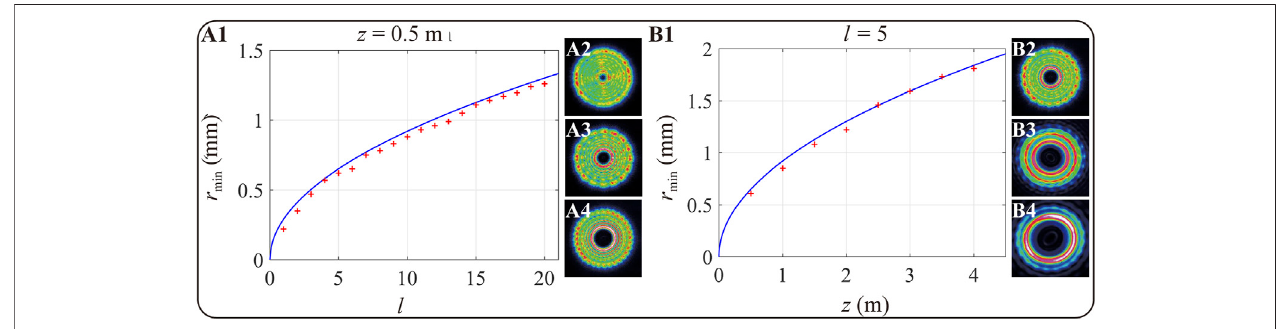
FIGURE4| Evolutionaryprocess oftheminimum radius ofthe darkring ofavortex beam variation with l and z in theexperiment. Therelationship between r min and (A1) the topological number l and (B1) the propagation distance z . The blue solid line is the simulation result, and the “ + ” marks are the experimental results. The measured intensity distributions for the vortex beam (A2 – A4) at the propagation distance z = 0.5 m with the topological number l are 1, 4, and 8, and (B2 – B4) the topological number l = 5 and the propagation distance z are 0.5, 1.5 and 2.5 m, respectively. All images have the same dimension of 6.2 mm × 6.2